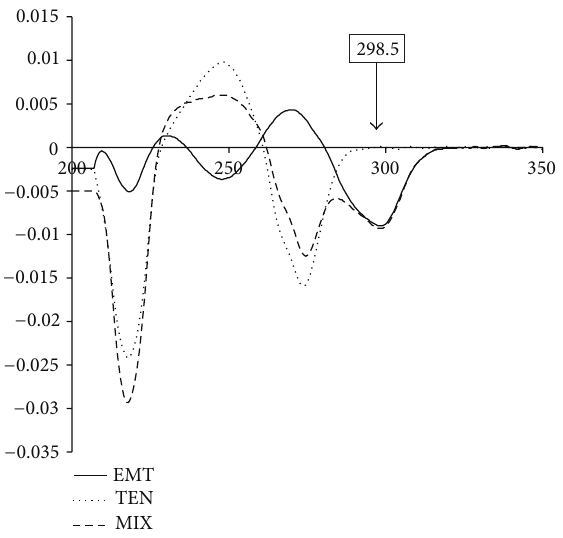
Figure 3: First derivative spectra of 1 𝜇 g mL −1 EMT, 1 𝜇 gmL −1 TEN, and their mixture in distilled water.